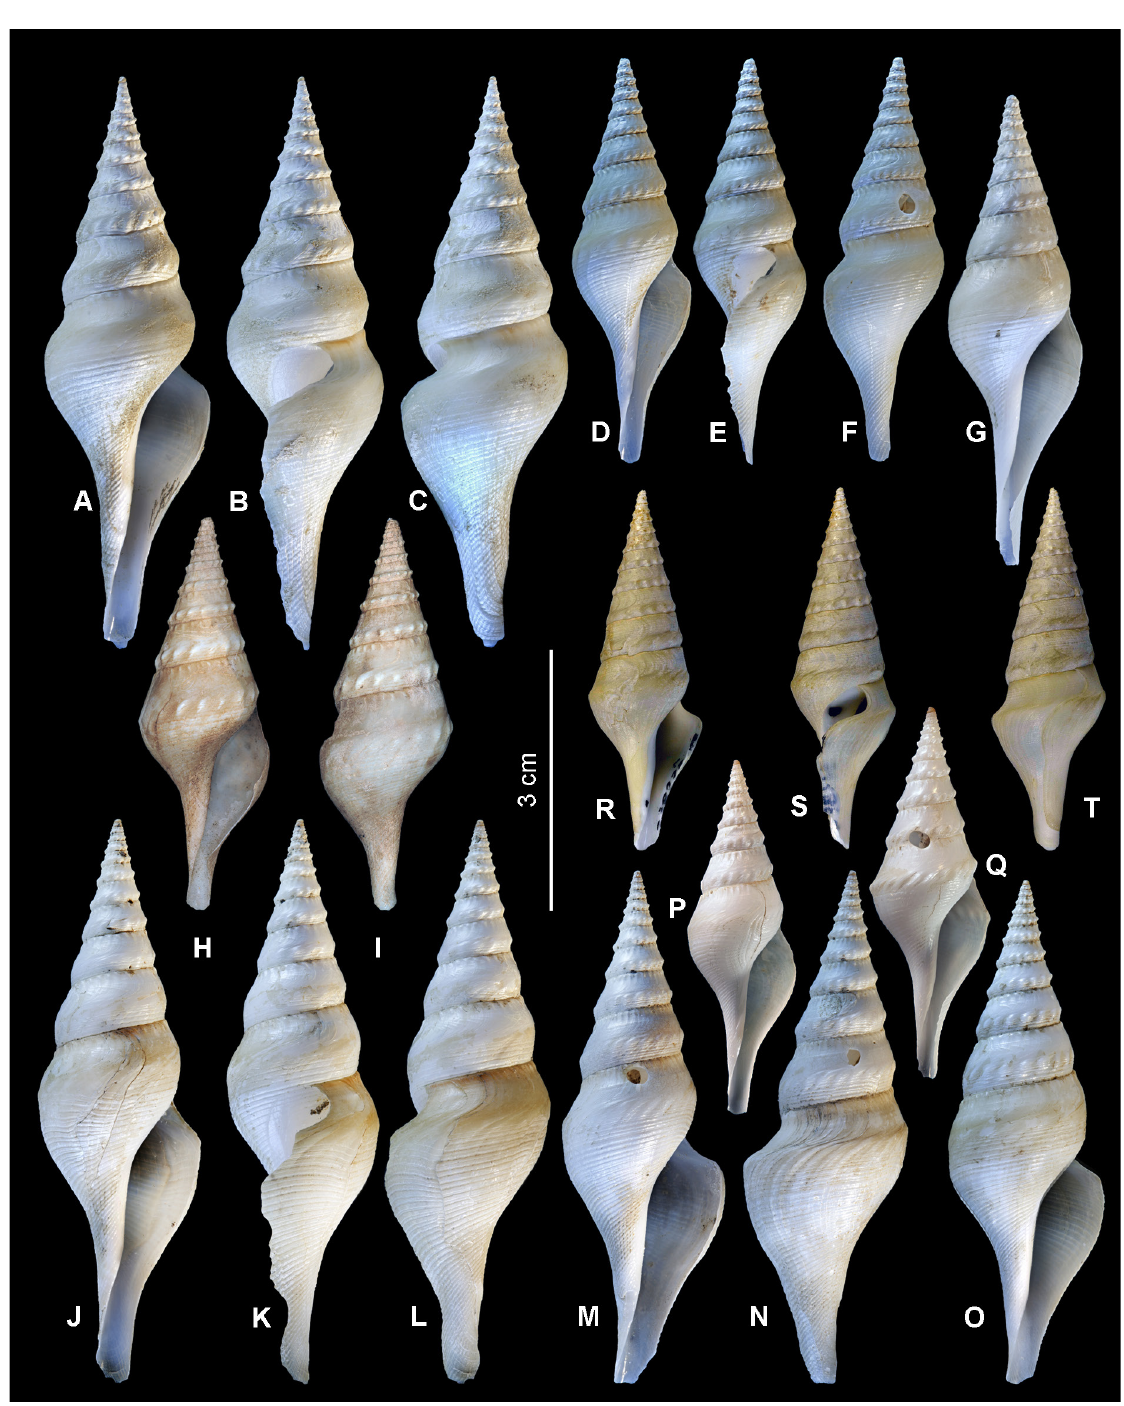
Fig. 3. Sibogasyrinx pyramidalis (Schepman, 1913) complex. A–G . Sibogasyrinx cf. pyramidalis 1. A–C . South China Sea, MNHN-IM-2013-44605, SL 65.2 mm. D–F . Philippines,